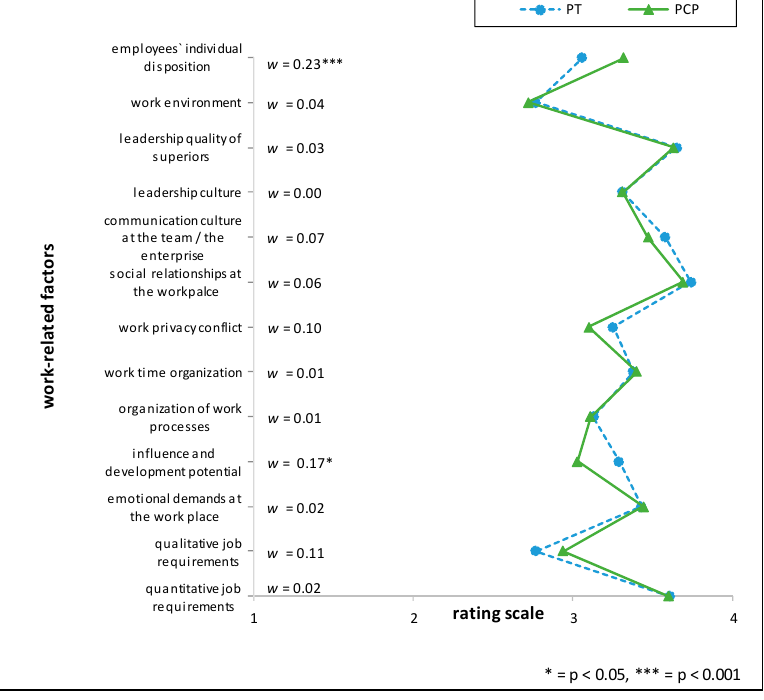
Figure 6. Polarity profile across work-related factors potentially important for (stress-associated) mental disorders in employees comparing the mean value ratings from “not at all important” (1) to “very important” (4) of Primary Care Physicians (PCP) and Psychotherapists (PT), w = effect size of differences.